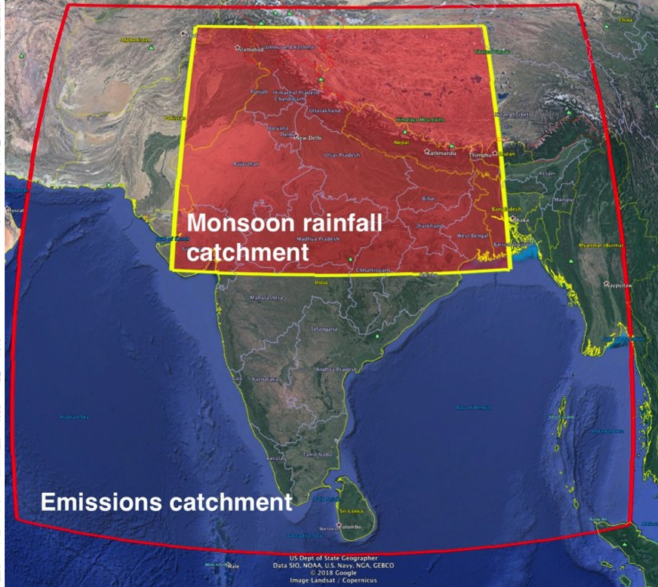
Figure 1. Graphic of the catchment areas used by Guo et al. for SO 2 emissions and ISMR change (coordinates from [13] (pp. 6943, 6952), visualised in Reference